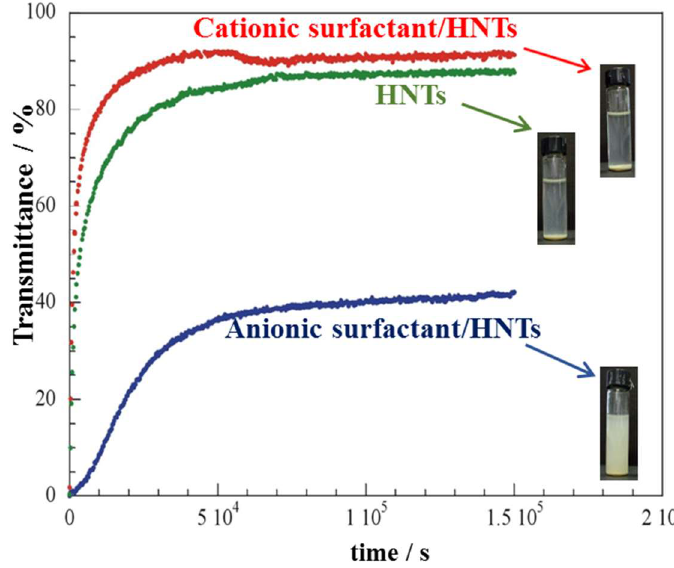
Figure 2. Halloysite nanotubes (HNTs) and surfactant-functionalized HNT dispersions (1 wt %) in water: photographs and transmittance as a function of time. Adapted from [56].